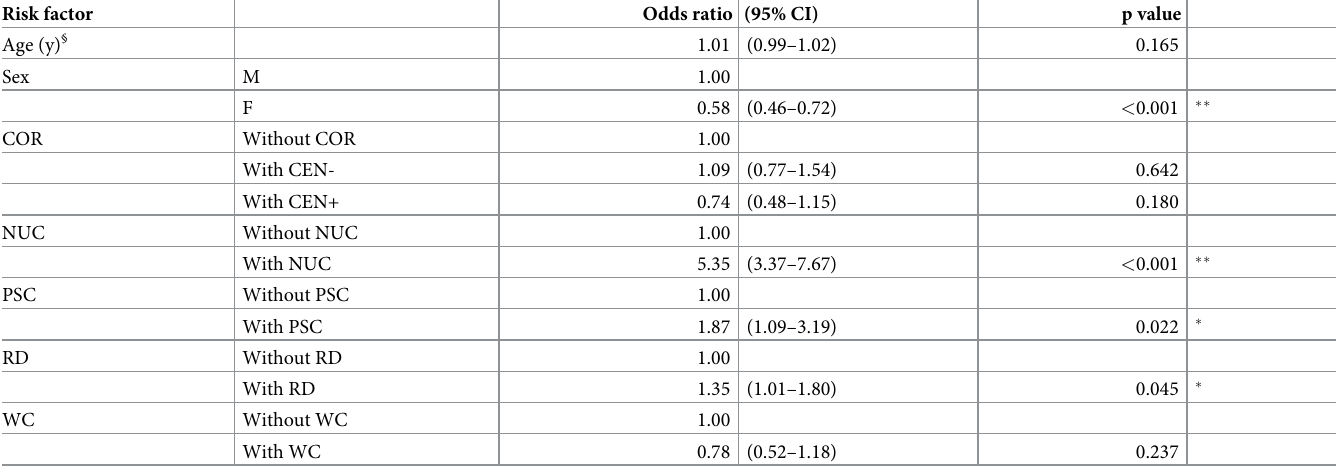
Table 4. Risk of the five types of cataract in the high cumulative ocular UV exposure (COUV) group compared with the low COUV group (adjusted for age, sex, axial length, and